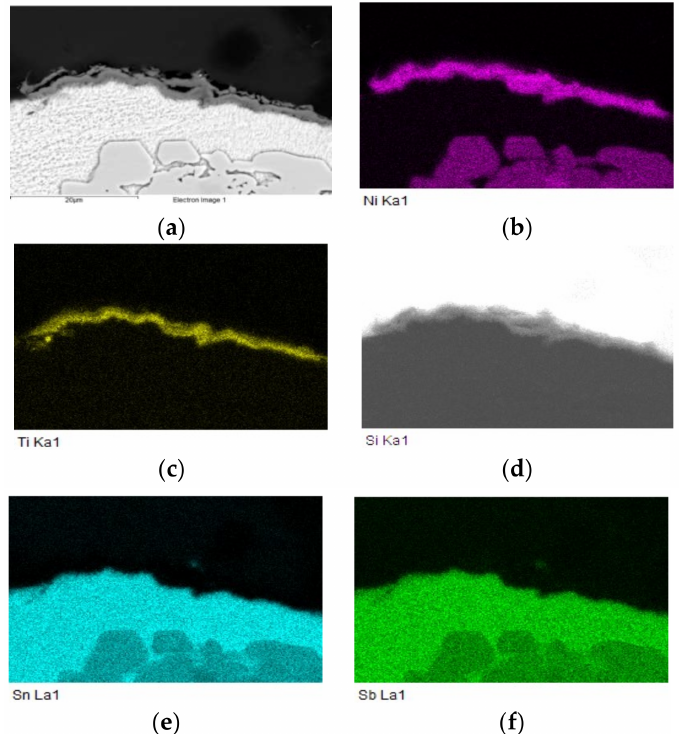
Figure 14. Planar distribution of Ni, Ti, Si, Sn and Sb elements on the boundary of SiC/Sn5Sb3Ti joint; ( a ) boundary; ( b ) Ni; ( c ) Ti; ( d ) Si; ( e ) Sn; ( f )